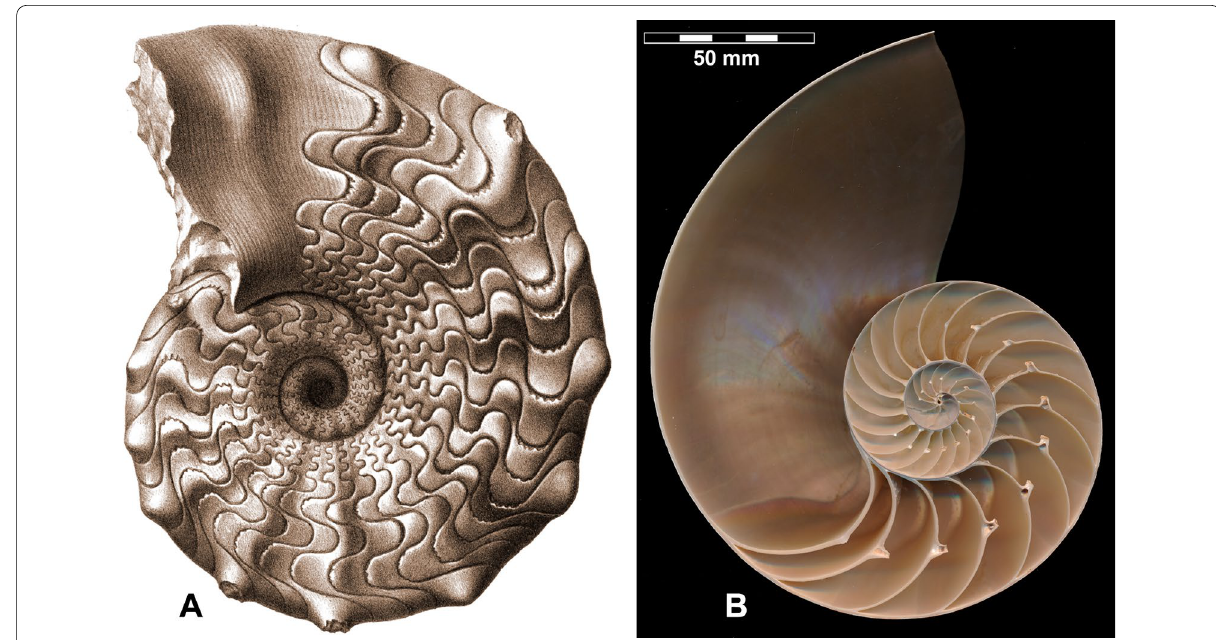
Fig. 1 A Mature specimen of Ceratites nodosus with terminal septal crowding (from von Buch, 1849). B Longitudinally sectioned specimen of Nautilus pompilius (specimen MB.C.30283, from unknown locality) with shortened terminal phragmocone chamber and thickened wall of the terminal